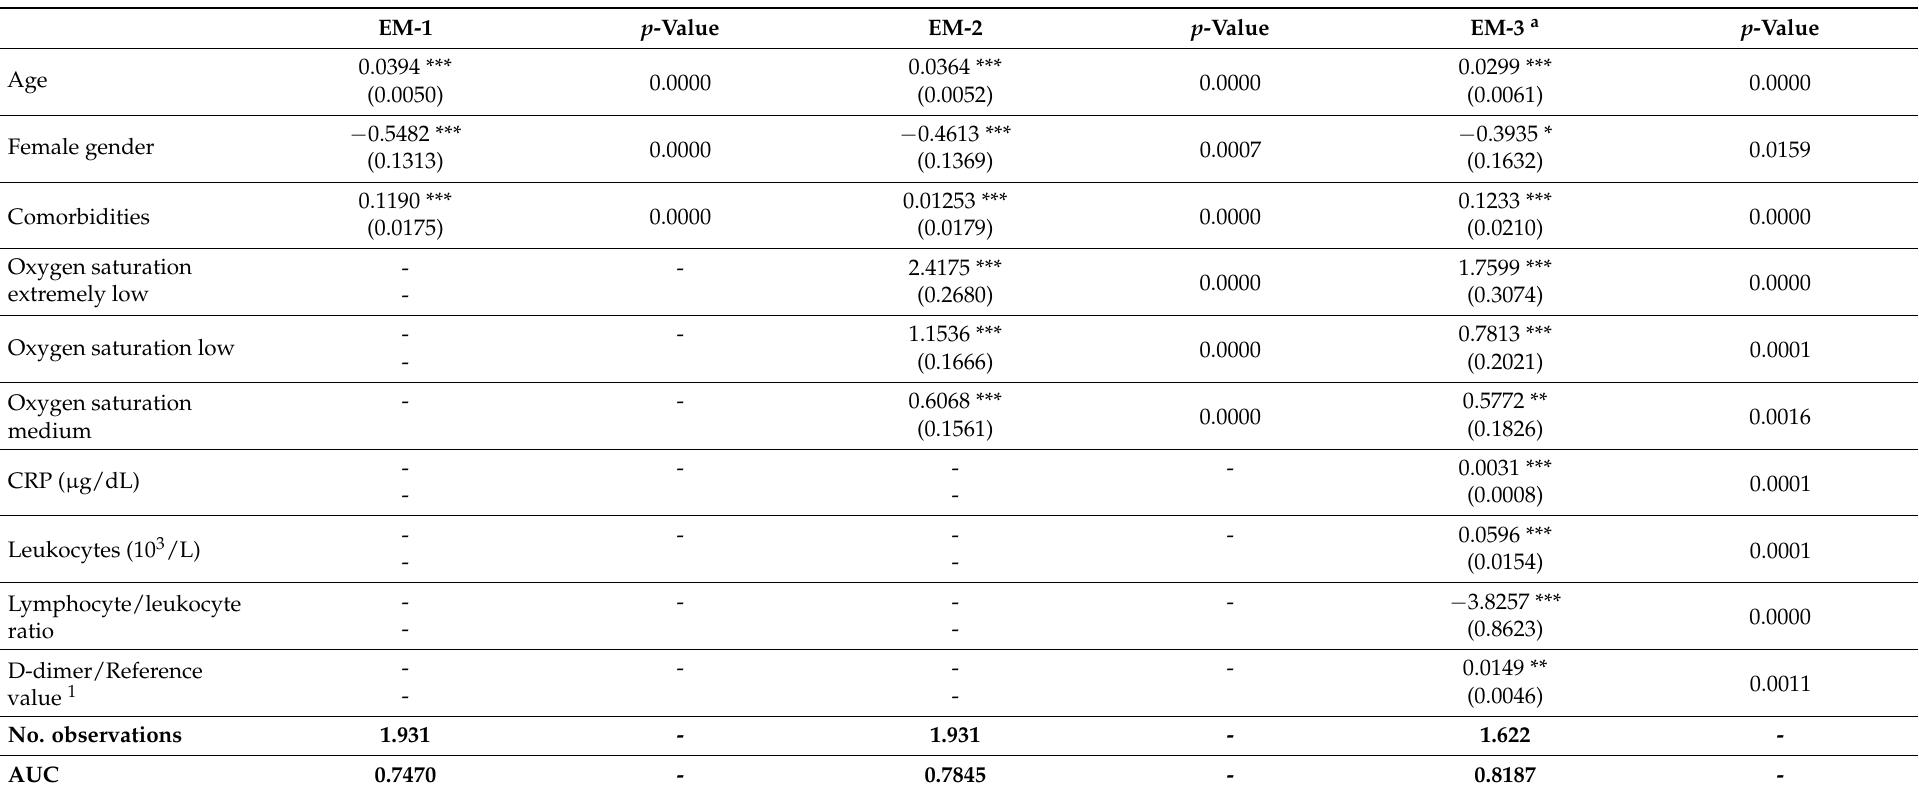
Table 3. Estimated parameters of the models in Grupo Hospitales de Madrid (CH-HM) dataset. Standard errors in brackets. AUC = area under the